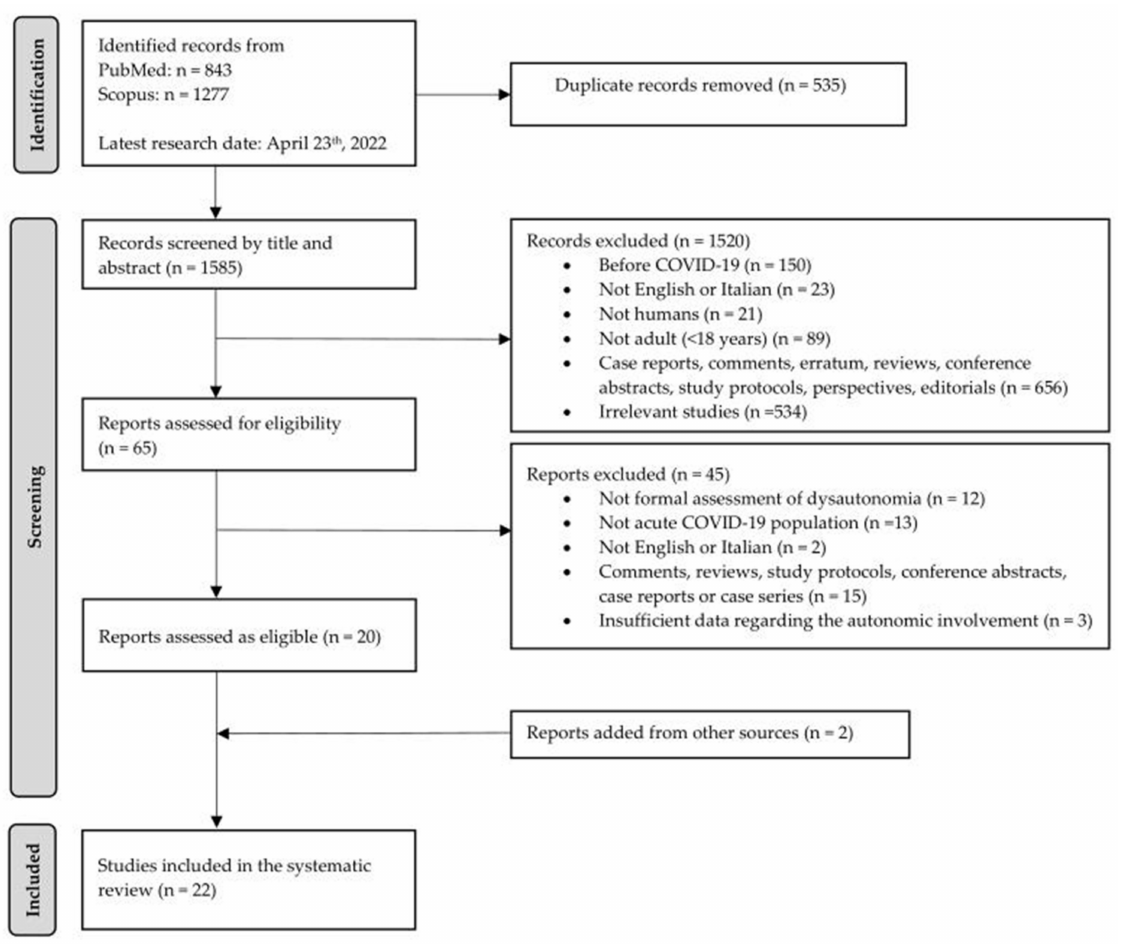
Figure 1. The PRISMA diagram of the systematic review. Reports excluded: Not formal assessment of dysautonomia—Refs. [66–77]; not acute COVID-19 population—Refs. [78–90]; not in English or Italian—Refs. [49,50]; study design—Refs. [51–65]; insufficient data regarding the autonomic involvement—Refs. [91–93]. Reports assessed as eligible—Refs. [29–48]. Reports added from other sources—Refs. [94,95]. Studies included in the systematic review—Refs. [29–48,94,95]. Abbreviations: COVID-19, Coronavirus disease